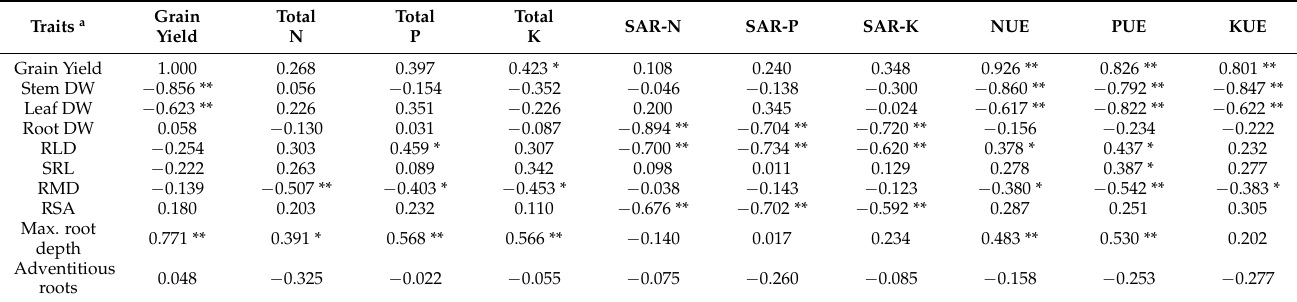
Table 4. Correlation analysis of the main morpho-agronomic traits at the end of water stresses with grain yield, total uptake of N, P and K, specific absorption rates (SAR-N, SAR-P and SAR-K), nutrient use efficiencies (NUE, PUE and KUE) at maturity in